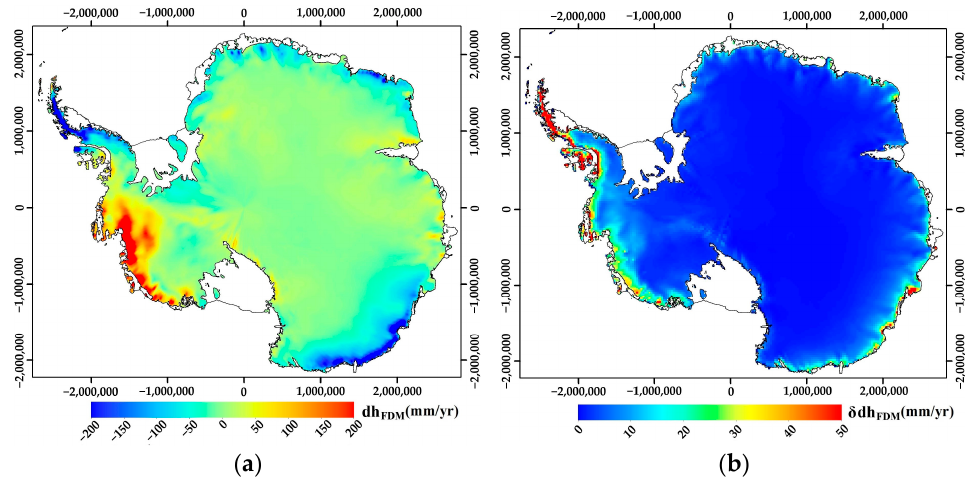
Figure 6. ( a ) Linear height variations trend derived from IAMU-FDM over the study period and ( b ) associated uncertainties.